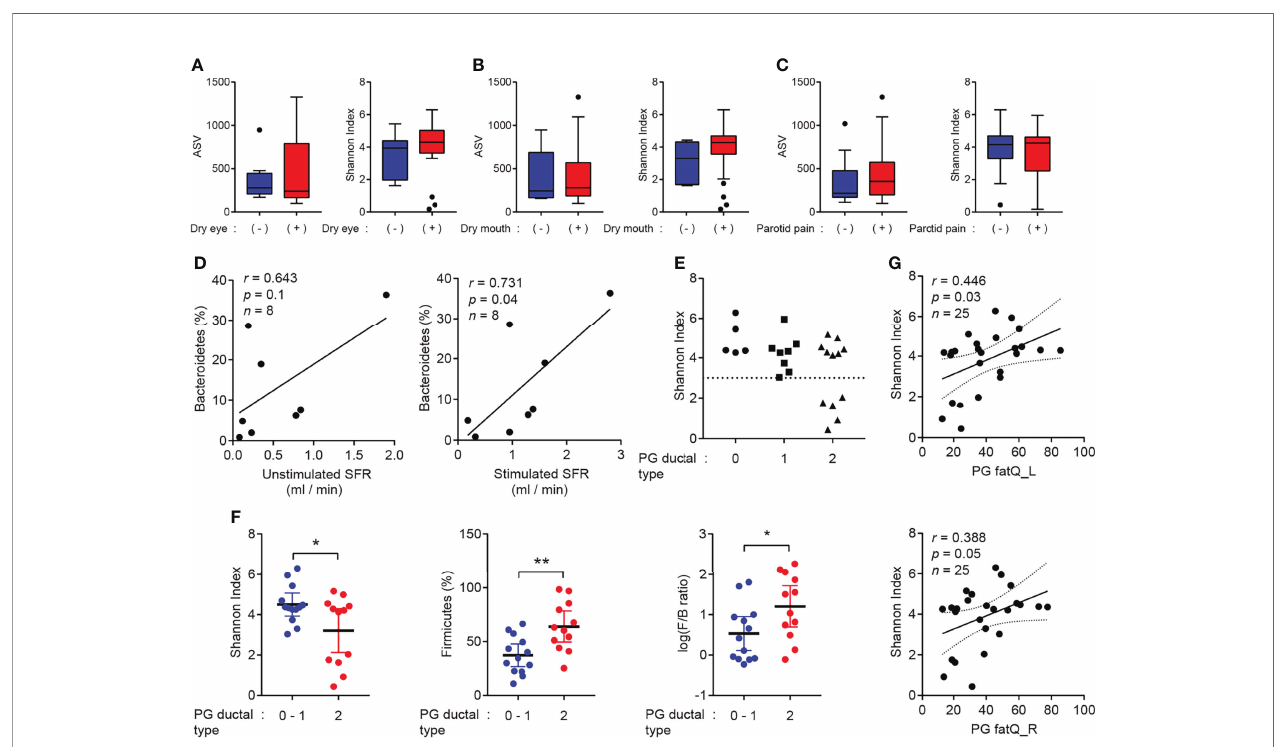
FIGURE 3 | Correlation of salivary gland microbiome with clinical indicators. (A – C) ASV (left) and Shannon index (right) were compared based on the presence of dry eye symptoms (negative, n = 14; positive, n = 18) (A) , dry mouth symptoms (negative, n = 5; positive, n = 27) (B) , or parotid swelling/pain/discomfort (negative, n = 11; positive, n = 21) (C) . (D) Correlation between unstimulated whole mouth salivary fl ow rate (UWMSFR, left), stimulated whole mouth salivary fl ow rate (SWMSFR, right), and abundance of Bacteroidetes ( n = 8). Solid lines indicated linear regression of data. (E) Ductal type of parotid gland (PG) was graded using magnetic resonance sialography images. Shannon index was compared among different groups of PG ductal type (0 = normal, 1 = stenosis, and 2 = sialectasis). Dotted line represents a Shannon index of 3. (F) Shannon index (left), abundance of Firmicutes (middle), and log-scaled F/B ratio (right) were compared between PG ductal types 0 – 1 and PG ductal type 2. (G) Correlation between fat deposition in left parotid gland (top), fat deposition in right PG (bottom), and Shannon index ( n = 25). Solid lines indicate linear regression of data, while dotted lines indicate con fi dence intervals of 95%. Data are represented as mean ± 95% con fi dence interval. * p < 0.05, ** p <